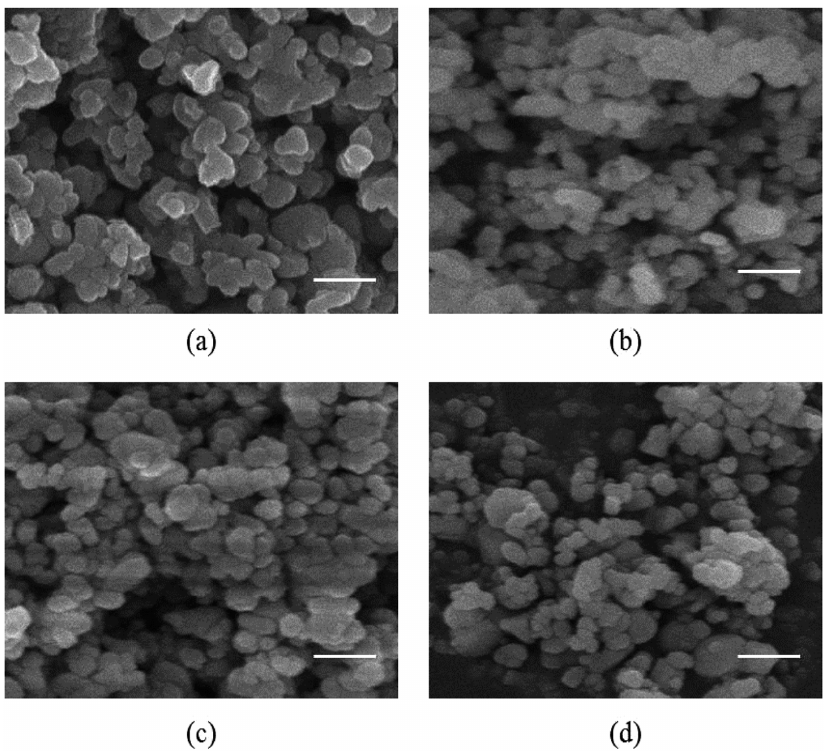
Figure 5: SEM images of calcined samples: (a) Mg 0.1 Zn 0.9 Fe 2 O 4 , (b) Mg 0.3 Zn 0.7 Fe 2 O 4 , (c) Mg 0.7 Zn 0.3 Fe 2 O 4 , and (d) Mg 0.9 Zn 0.1 Fe 2 O 4 with scale bar of 2